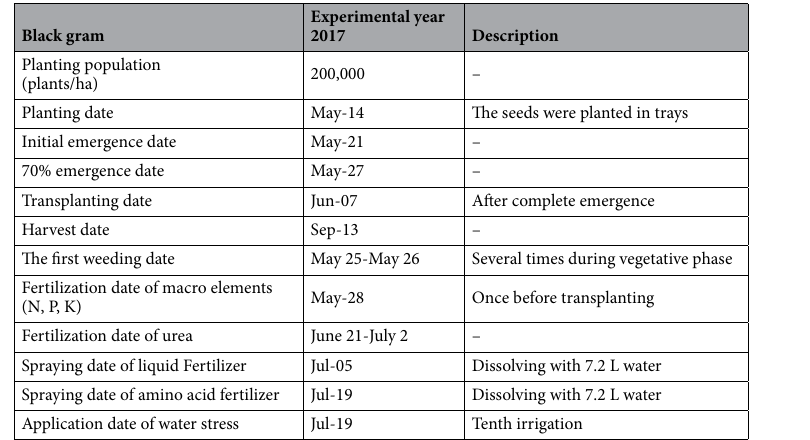
Table 1. Agronomic details and dates for field